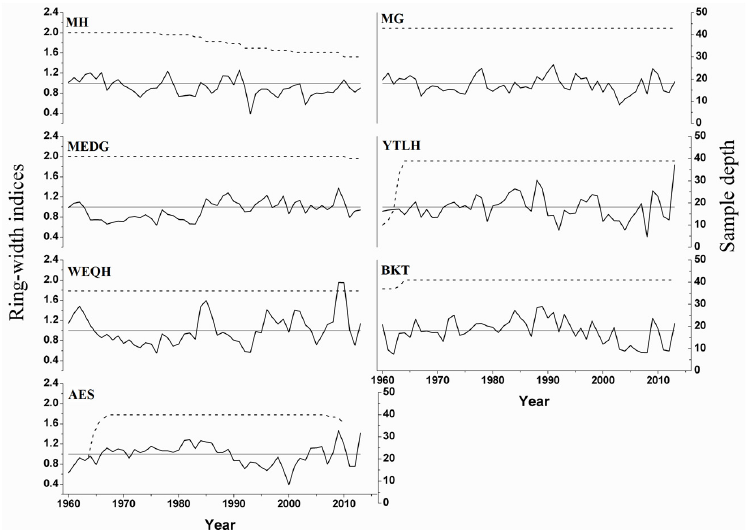
Figure 3. Ring ‐ width residual chronologies for the period 1960–2013 constructed for Larix gmelinii along the latitudinal gradient from 47.27° to 52.66° N at the seven sites (panels) in the Greater Khingan Mountains of the western Chinese boreal forest. The dashed lines indicate the numbers of tree ‐ ring series. Table 2. Statistical characteristics of Larix gmelinii residual chronologies along the latitudinal gradient from 47° to 53° N in the western Greater Khingan Mountains, China.